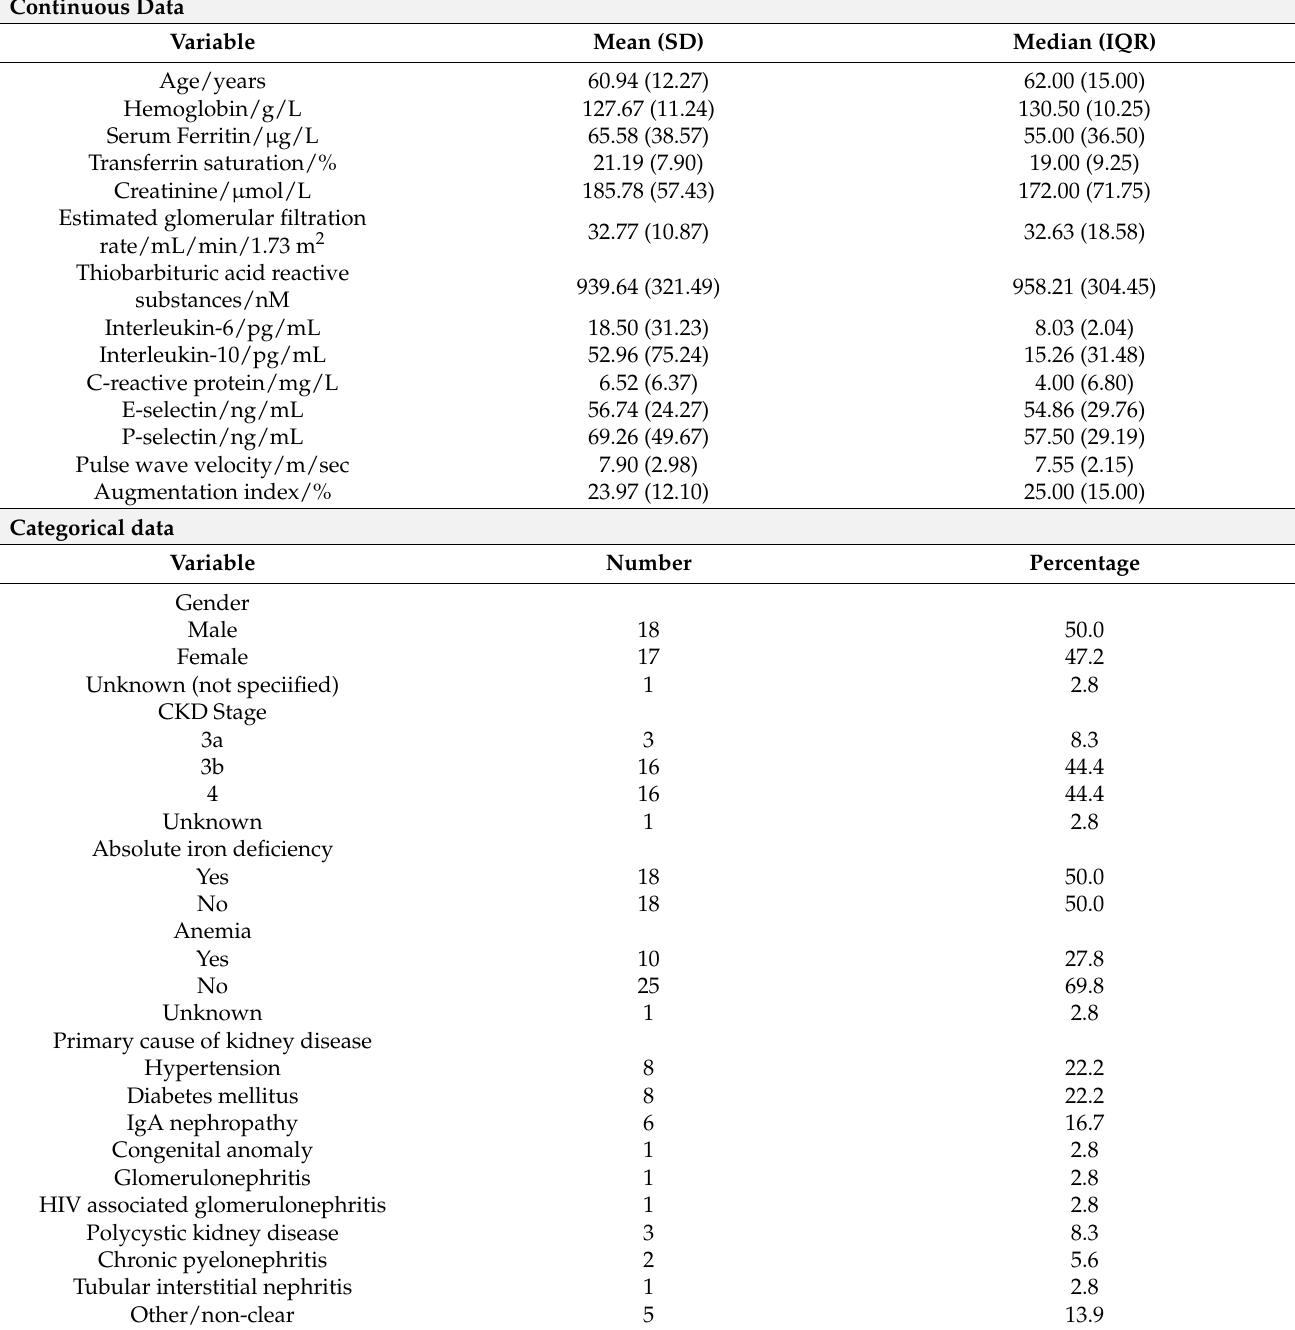
Table 1. Baseline